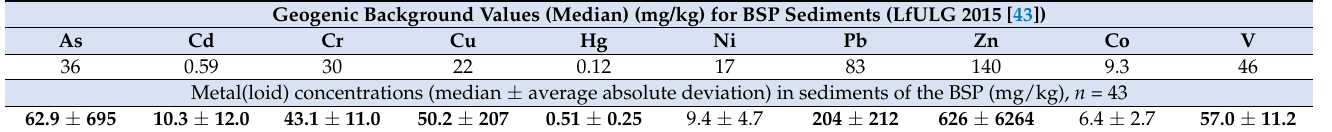
Table 4. Comparison of the geogenic background values for the Saxon topsoils on gneiss (land use: agriculture) [43] with the measured element concentrations in the sediments of the Berthelsdorf Smelter Pond (BSP). Values in bold exceeded the background